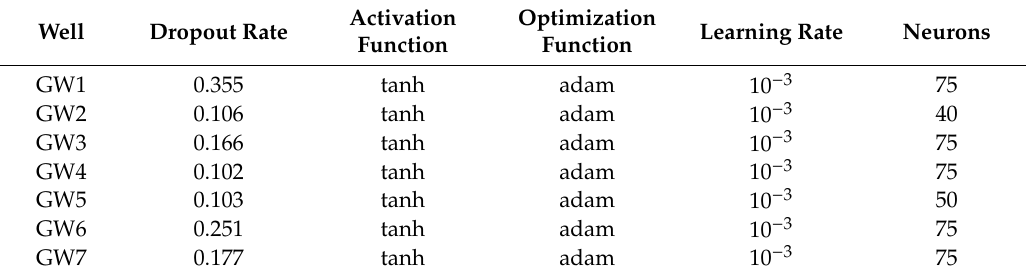
Table 9. Tuned hyperparameters for LSTM